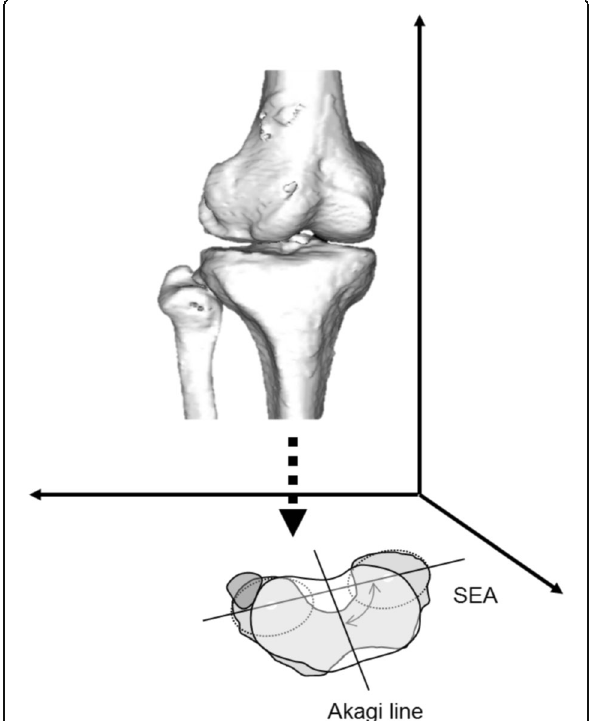
Fig. 4 Schematic illustration of rotational alignment in a three dimensional